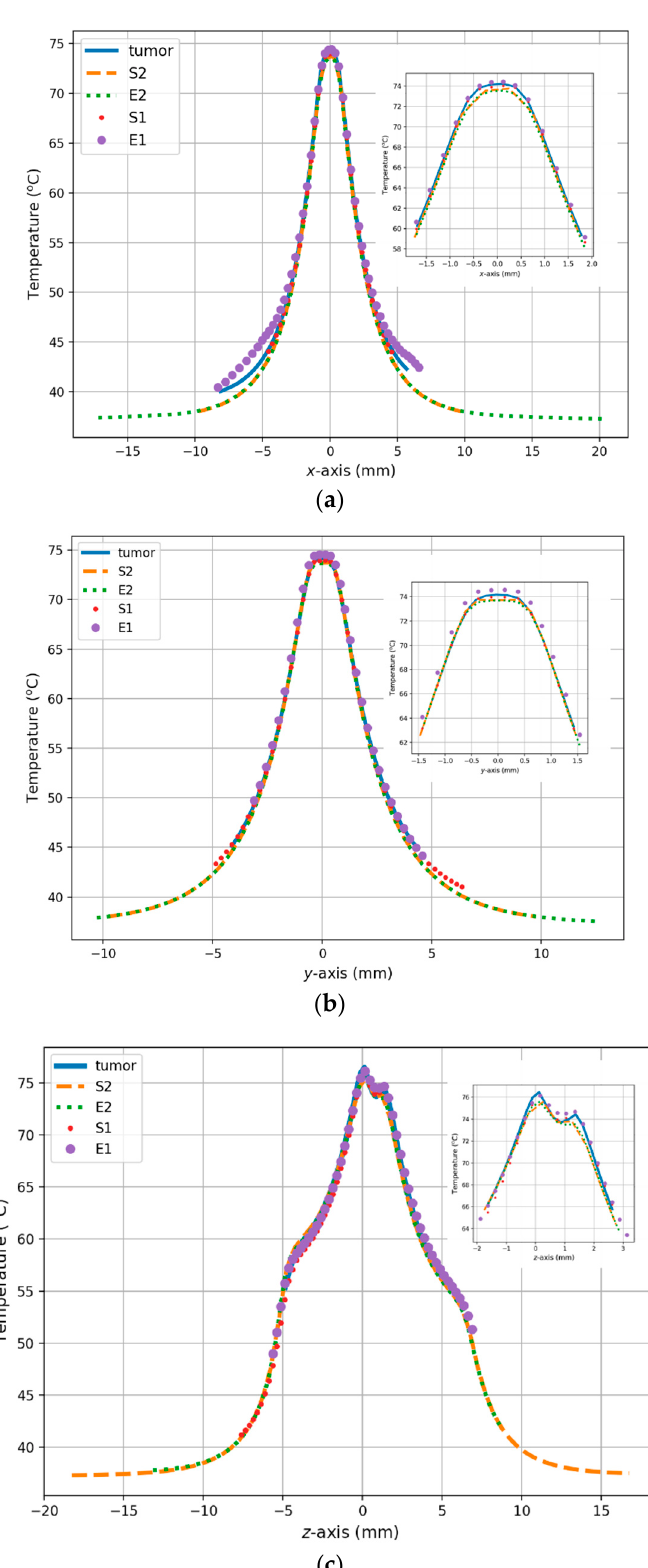
Figure 8. Temperature distributions along different axes of analyzed equivalent tumor models: ( a ) x -axis; ( b ) y -axis; ( c ) z -axis, where S 1 and S 2 are spherically equivalent tumor models; and E 1 and E 2 ellipsoidal equivalent tumor models.